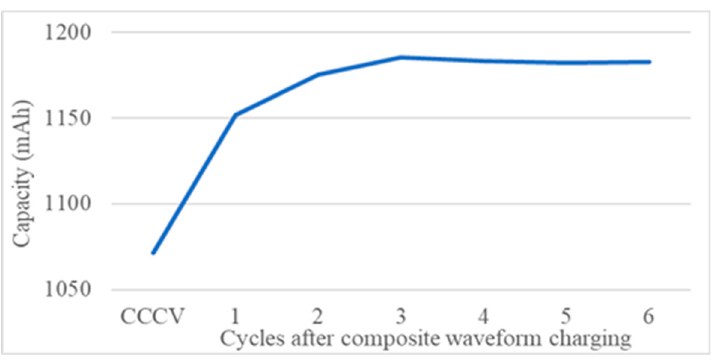
Figure 7. Verification of the applied charging performance.